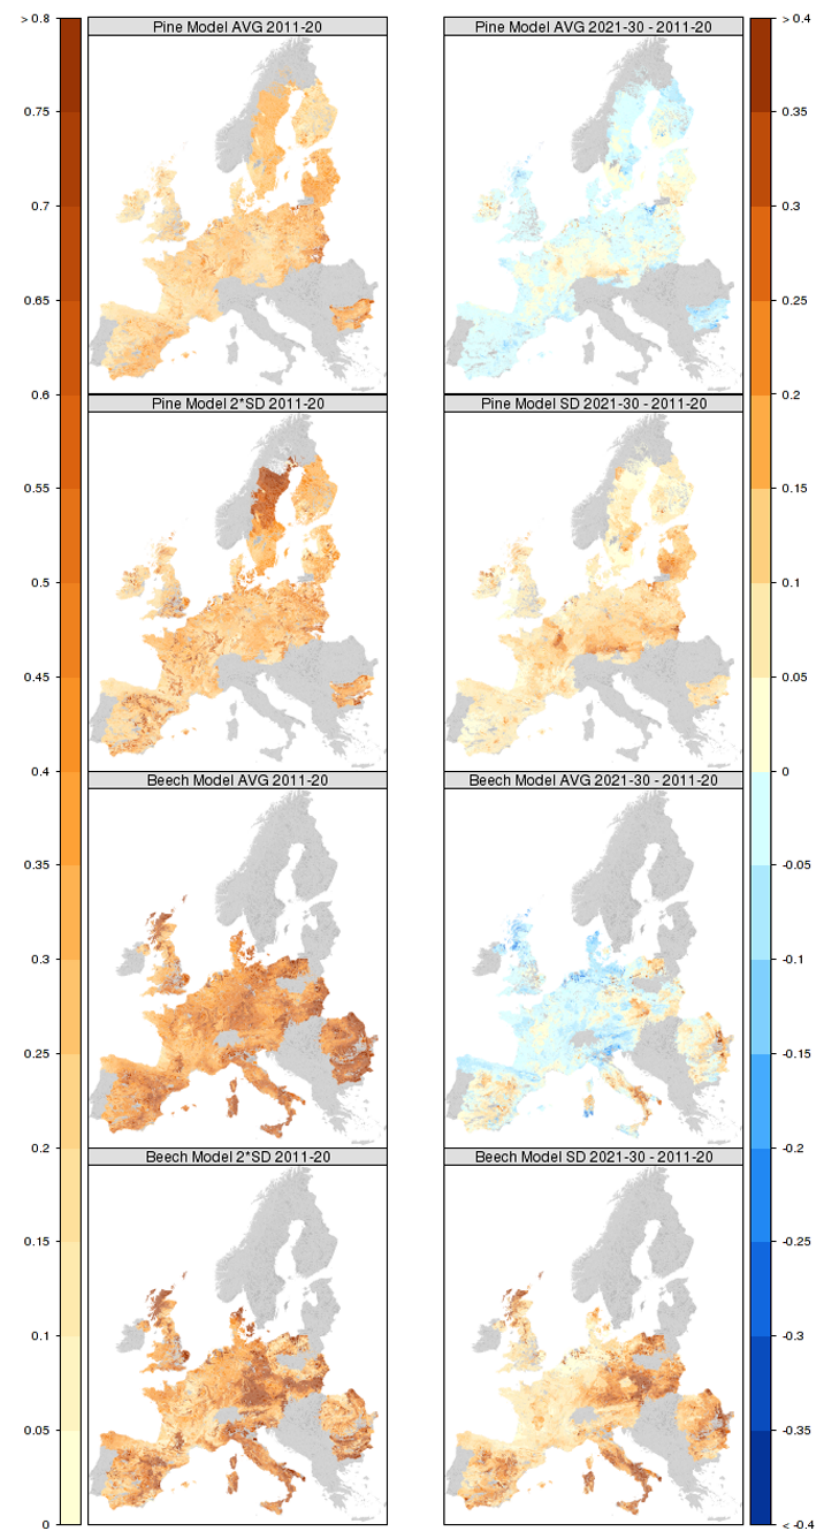
Fig. 6. N 2 O (kgNha − 1 yr − 1 ) for Scots pine and European beech. The first and third rows are averages over the models. The second and fourth rows are standard deviations (right column) or two times standard deviations (left column) over the models. The left column is the decadal average 2011–2020. The right column is the difference in decadal average 2021–2030 minus